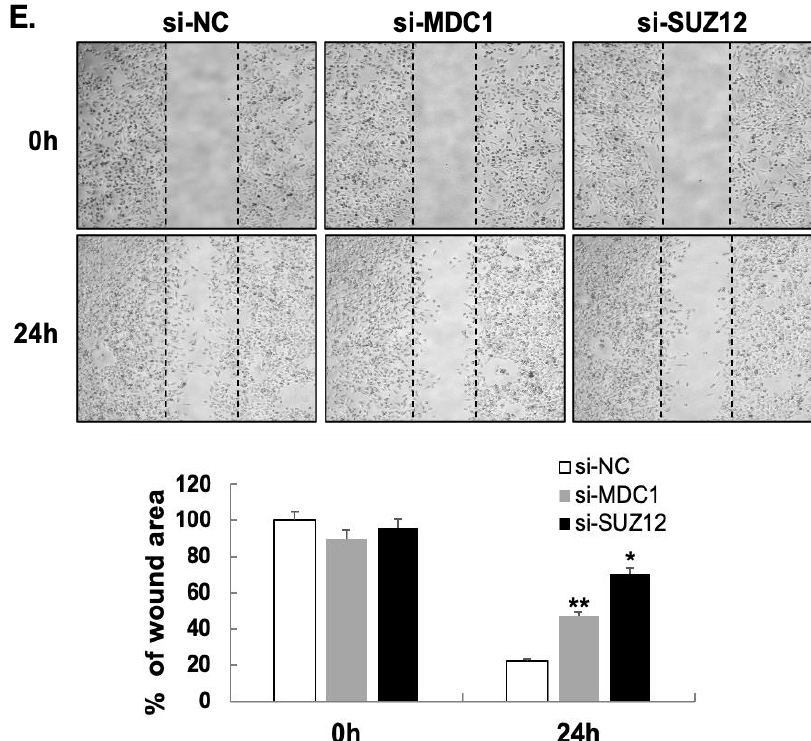
Figure 2. MDC1 and SUZ12 are novel target genes of miR-489 in TNBC cells. ( A ) miR-489 binding sites are found in the 3’ UTRs of MDC1 and SUZ12. ( B ) MDA-MB-231, HCC-1937, MDA-MB-468 and BT-459 cells were transfected with control miRNA (miR-NC) and miR-489. Protein levels from cell lysates were analyzed by Western blot assay with antibodies against MDC1 and SUZ12. GAPDH levels were used as loading control. Densitometric analysis was performed using Image J. Representative images were carried out at least three times. ( C ) MDA-MB-231 cells were transfected with 40 nM siRNA